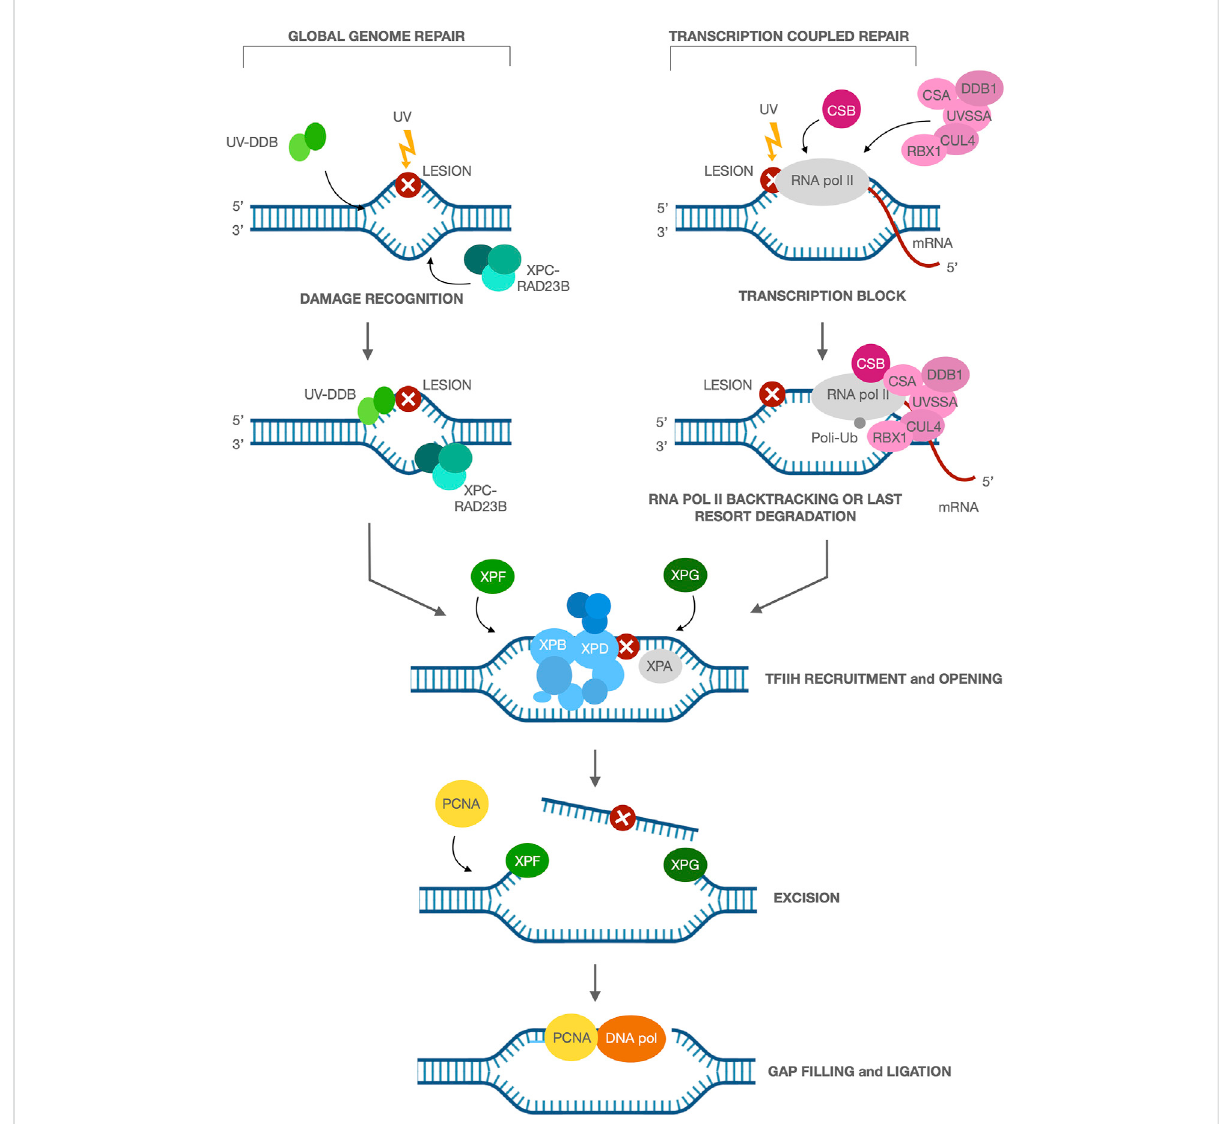
FIGURE 1 Nucleotideexcisionrepairanditstwosub-pathways.Globalgenomerepair(GGR):theUV-inducedDNAdamageisrecognizedandremovedby GGR, that involves several proteins acting in tandem, including the UV-DDB and XPC-RAD23B, involved in damage recognition. Transcription coupledrepair(TCR):TCRistriggeredwhenelongatingRNApolIIisblockedbyDNAdamageinthetranscribedstrand.CSBisinvolvedintheinitiation of TCR through recognition of blocked RNA pol II and binding to this complex, followed by recruitment of the other NER proteins CSA, CUL4, RBX1,DDB1andUVSSAto thedamagedsite.Inboththesub-pathways, XPBandXPDhelicases,which arepartofTFIIH,arerecruitedatthelesionfor the DNA unwinding. XPA protein maintains the open DNA region containing the damage, which is then cut out by XPF/ERCC1 and XPG endonucleases at the 3 ′ and 5 ′ ends of the damaged DNA, respectively. PCNA recruitment next favors the DNA polymerase action in fi lling in the resulting